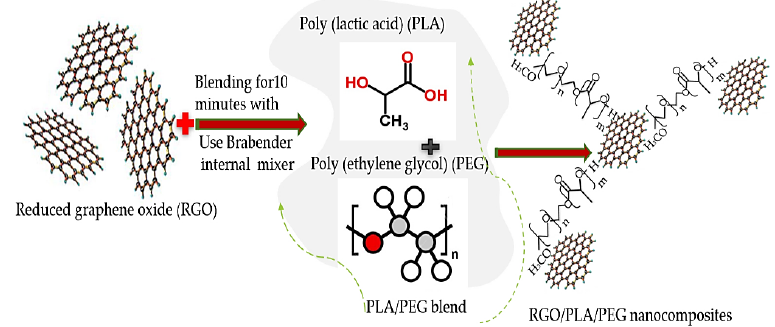
Figure 3. Schematic diagram for the synthesis of RGO/PLA/PEG nanocomposite.